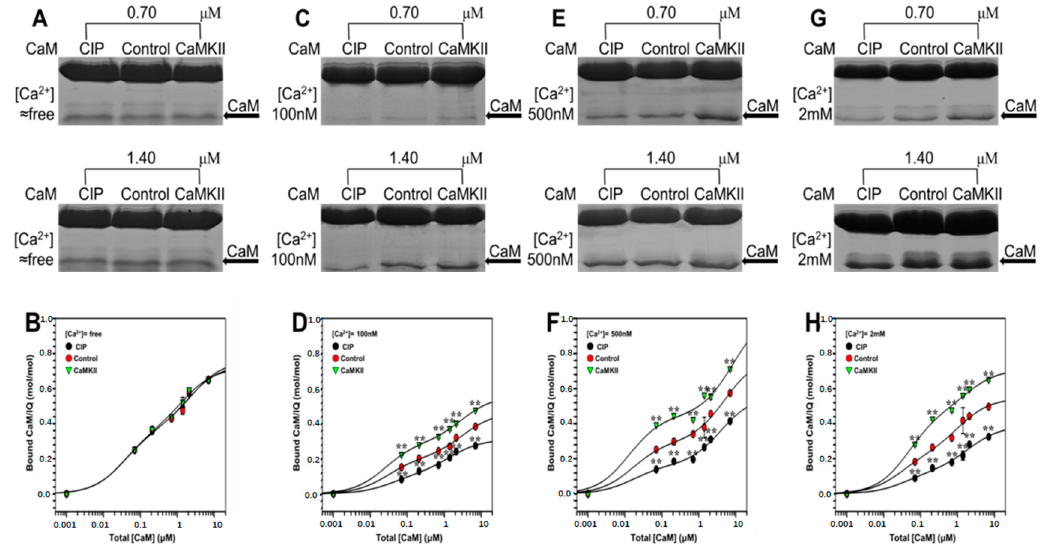
Figure 6. Regulation of CaMKII on CaM binding to Na V 1.1 IQ domain by pull-down assay. ( A , C , E , G ) GST pull down assay for the binding of CaM with CaMKII-meditated phosphorylation IQ. GST-fusion IQ was phosphorylated by CaMKII, then incubated with increasing concentration of CaM (0.07 to 7 µ m) at fixed [Ca 2+ ] of ≈ free, 100 nM, 500 nM, and 2 mM. Protein bands were stained by Coomassie Brilliant Blue. CaM bands are pointed out by arrows. ( B , D , F , H ) Bound CaM are plotted against total [CaM] on a molar ratio basis (CaM/GST-IQ) with mean ± S.E. ( n = 4). ** p < 0.01, compared with corresponding bindings at control conditions.